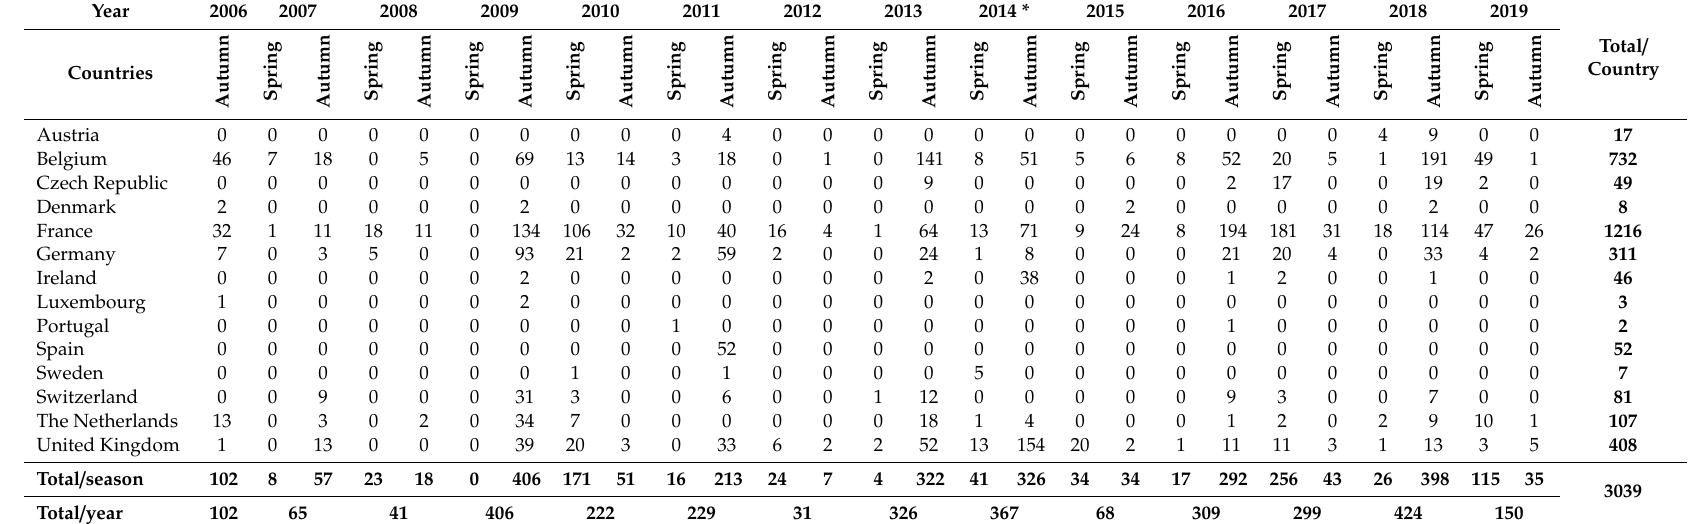
Table 1. Total number of atypical myopathy cases in Europe notified to the disease surveillance networks from autumn 2006 to November 2019 (n =